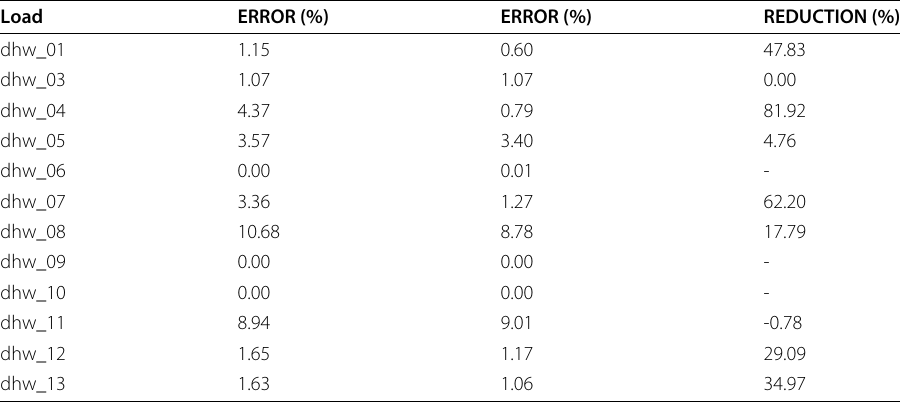
Table 5 Non intrusive load monitoring - Limiting the number of estimated